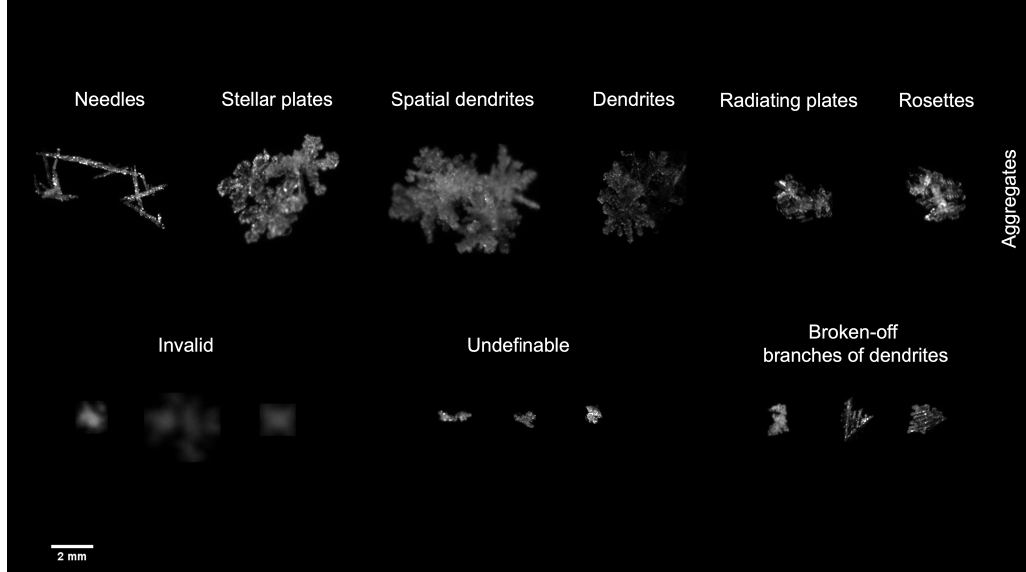
Figure A2. Similar to Fig. 2, but with further examples of images captured by the MASC. Aggregates of specifiable ice particle shapes are arranged in the top row. Invalid and undefinable particle shapes and broken-off branches of dendrites are shown in the bottom